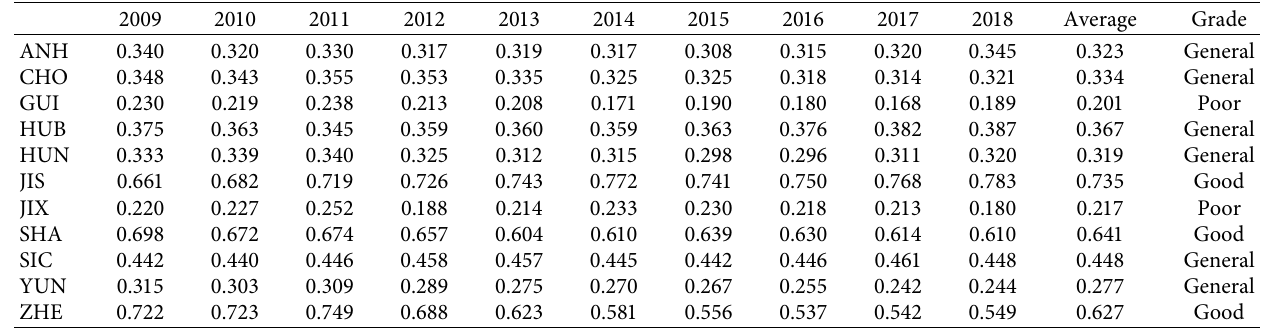
Figure 2: Temporal evolution of CDD for finance. Table 4: CDD of finance.